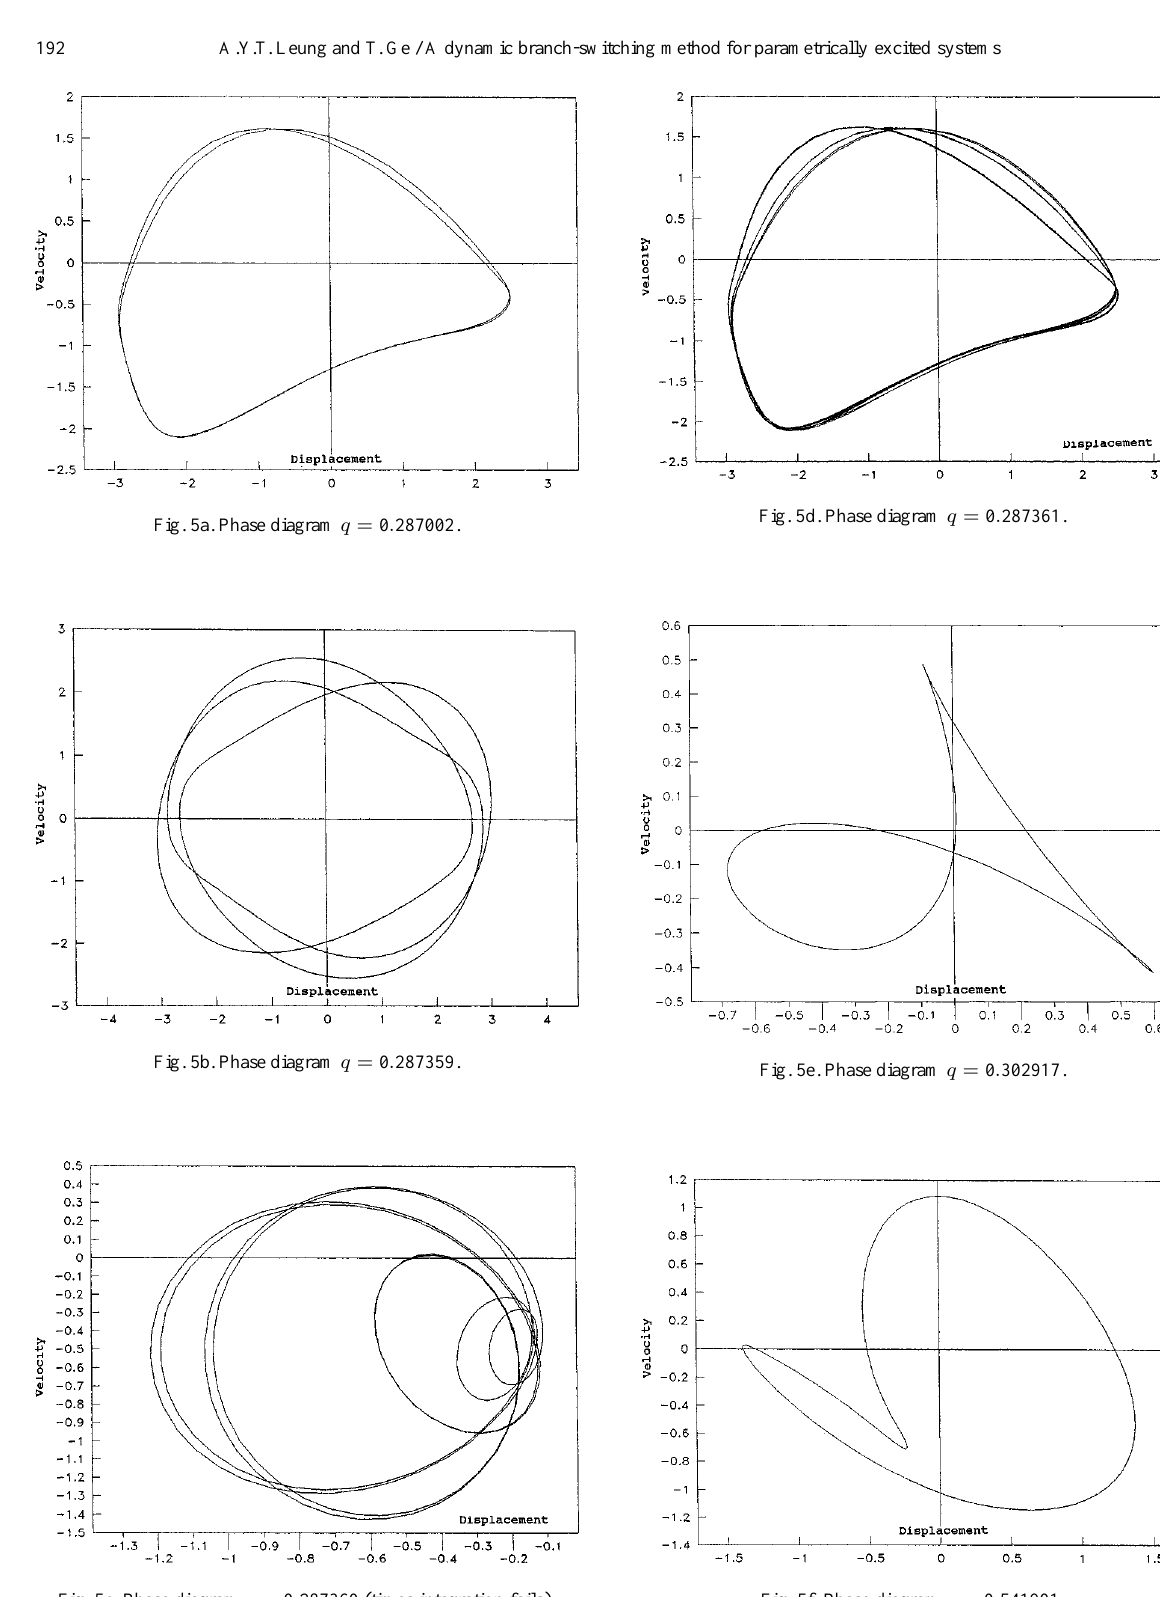
Fig. 5f. Phase diagram q = 0 :